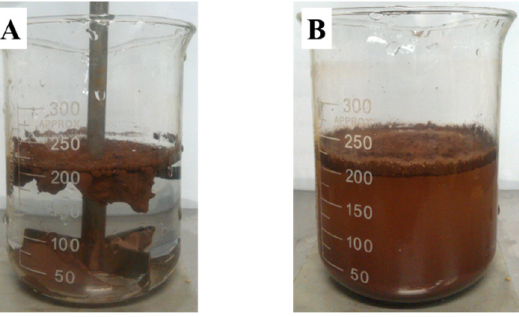
( d ) Figure 3. ( a – c ) SEM images and ( d ) EDS analysis of iron ore sintering dust. 3.2. Effects of Temperature and S/L Ratio A special surface feature could be easily observed before and after mixing, showing the aggregates formed after being poured into the water and partly floating on the water surface (Figure 4). Further, the higher the stirring speed is, the less the amount of dust